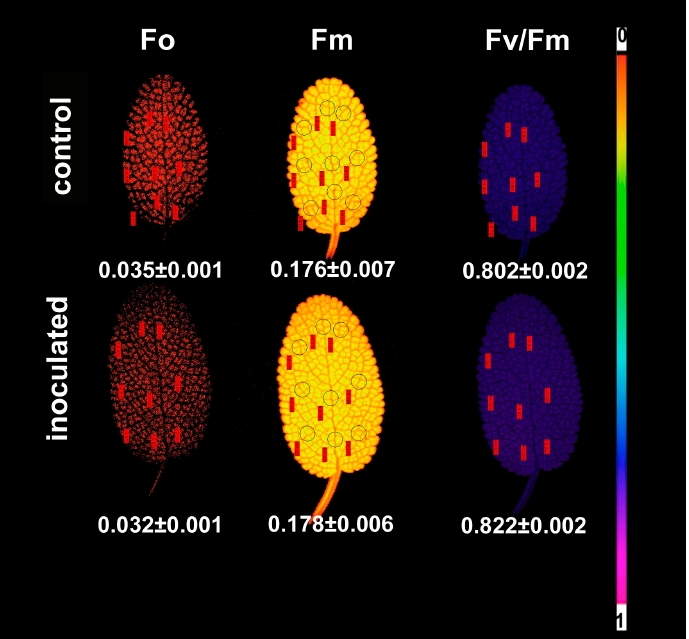
Figure 8. Representative chlorophyll a fluorescence images of the minimum chlorophyll a fluorescence in the dark-adapted leaf (F o ), the maximum chlorophyll a fluorescence in the dark-adapted leaf (F m ), and the maximum e ffi ciency of PSII photochemistry (F v / F m ) of Salvia fruticosa leaves from control (non-inoculated) and inoculated plants. The color code depicted at the right side of the image ranges from black (pixel values 0.0) to purple (1.0). The nine areas of interest (AOI) are shown in each image. The average value ( ± SD) of the whole leaf for each parameter is shown.